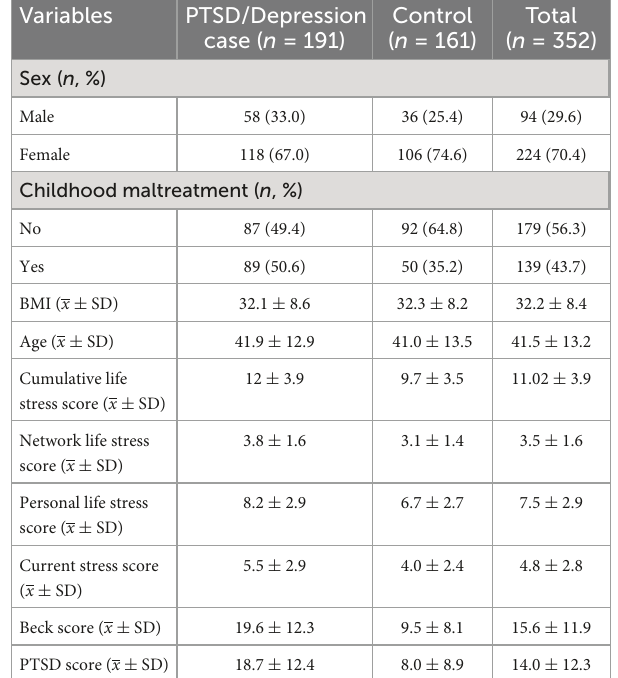
TABLE 1 Descriptive statistics for 352 participants in the GTP data after quality